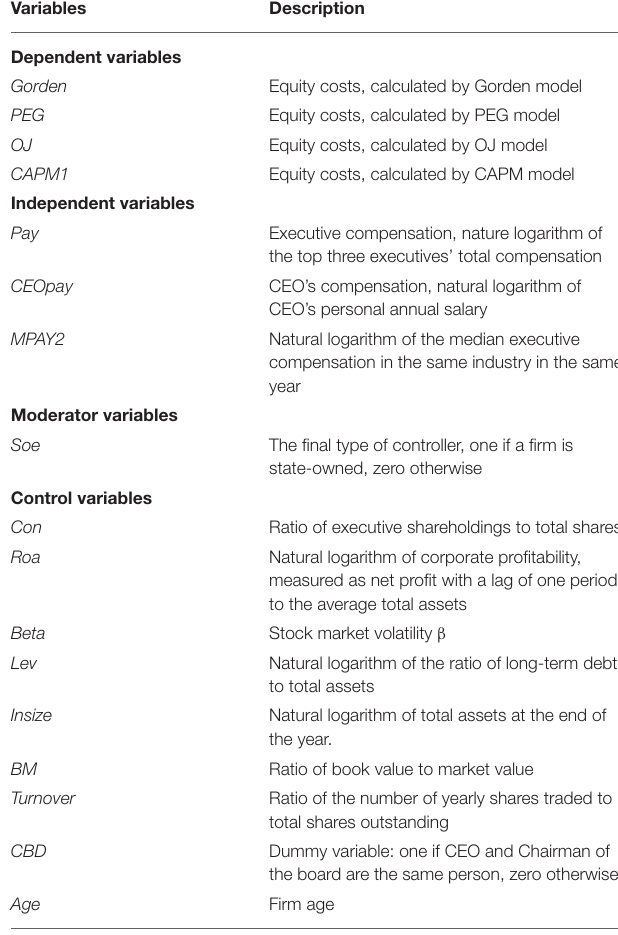
TABLE 1 | Variable